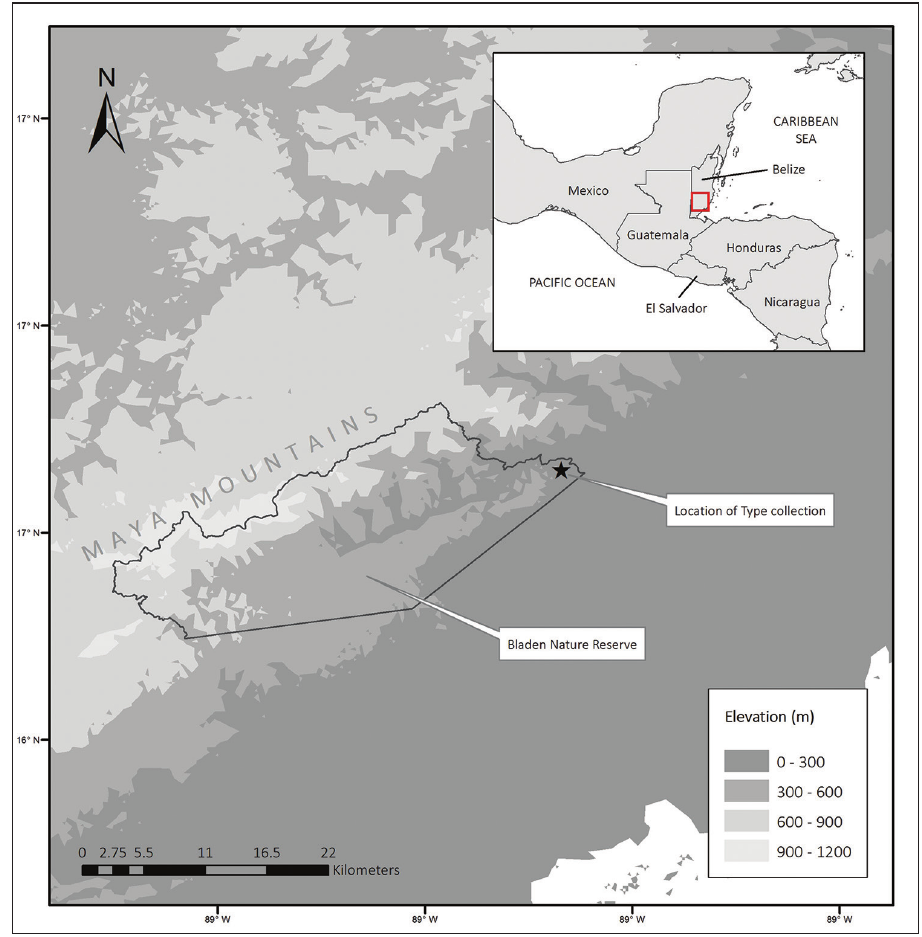
Figure 1. Elevation map of Belize with the type location (*) within the Bladen Nature